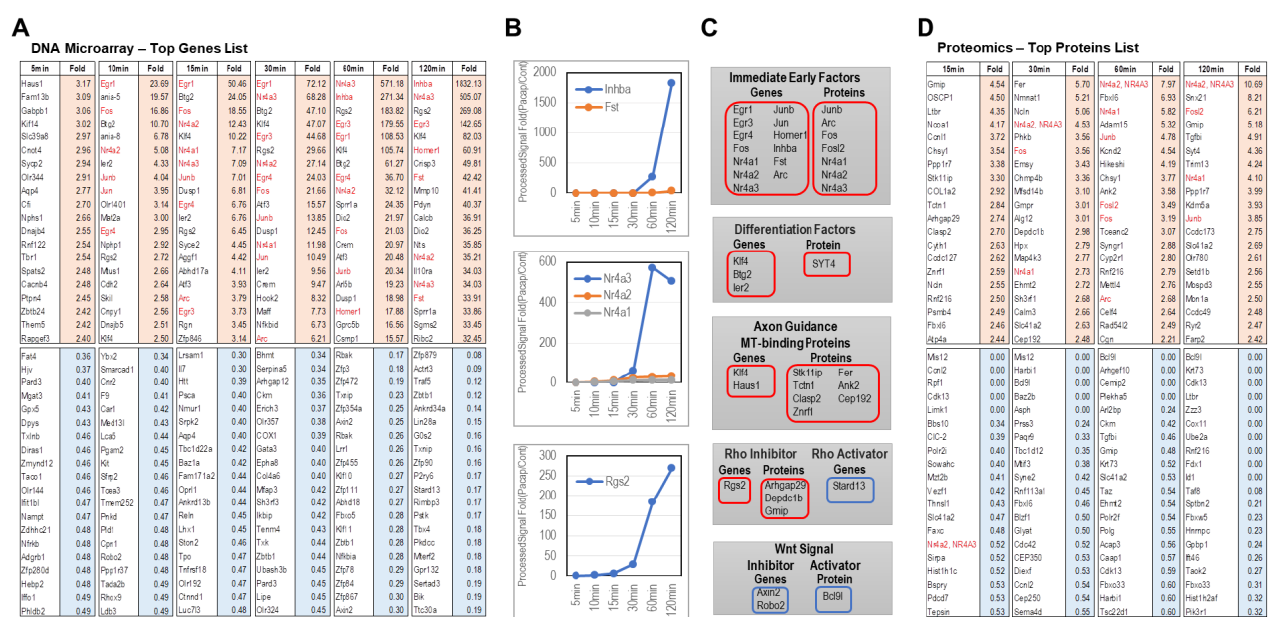
Figure 5. Top 20 genes and proteins whose expressions were altered by PACAP in the PC12 cells. ( A ) List of the top 20 genes whose expression was altered by DNA microarray analysis at 5, 10, 15, 30, 60, and 120 min after the addition of PACAP. ( B ) Expression changes of Inhba, Fst, NR4A1,2,3, and Rgs2 genes. Gene expression levels (ProcessedSignal) on the vertical axis are expressed as Fold (PACAP treatment/Control) values. ( C ) Top 20 genes and proteins with altered expression by PACAP, categorized as Initial Early Factors, Differentiation factors, Axon guidance, MT-binding proteins, Rho inhibitor, and genes and proteins categorized as Initial Early Factors are shown in red (up-regulated) and blue (down-regulated) boxes. ( D ) List of the top 20 proteins with altered expression obtained by TMT-LC-MS/MS analysis at 15, 30, 60, and 120 min after addition of